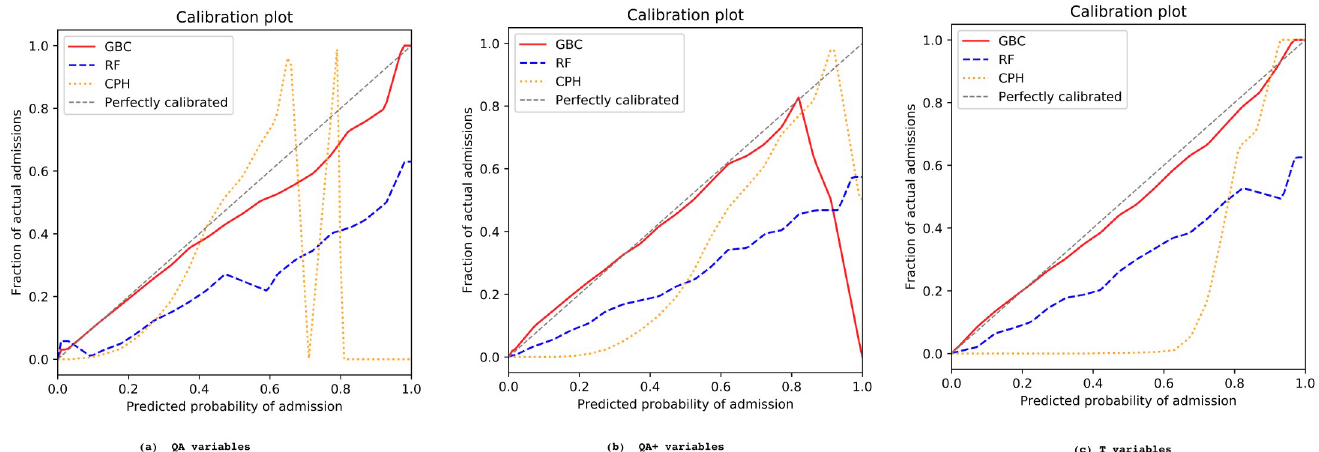
Fig 2. Externally validated model calibration for different predictor sets and modelling techniques. (a) QA variables; (b) QA+ variables; (c) T variables. The x - axis shows the predicted probability of emergency admission, while the y -axis shows the fraction of actual admissions for each predicted probability. CPH, Cox proportional hazards; GBC, gradient boosting classifier; RF, random